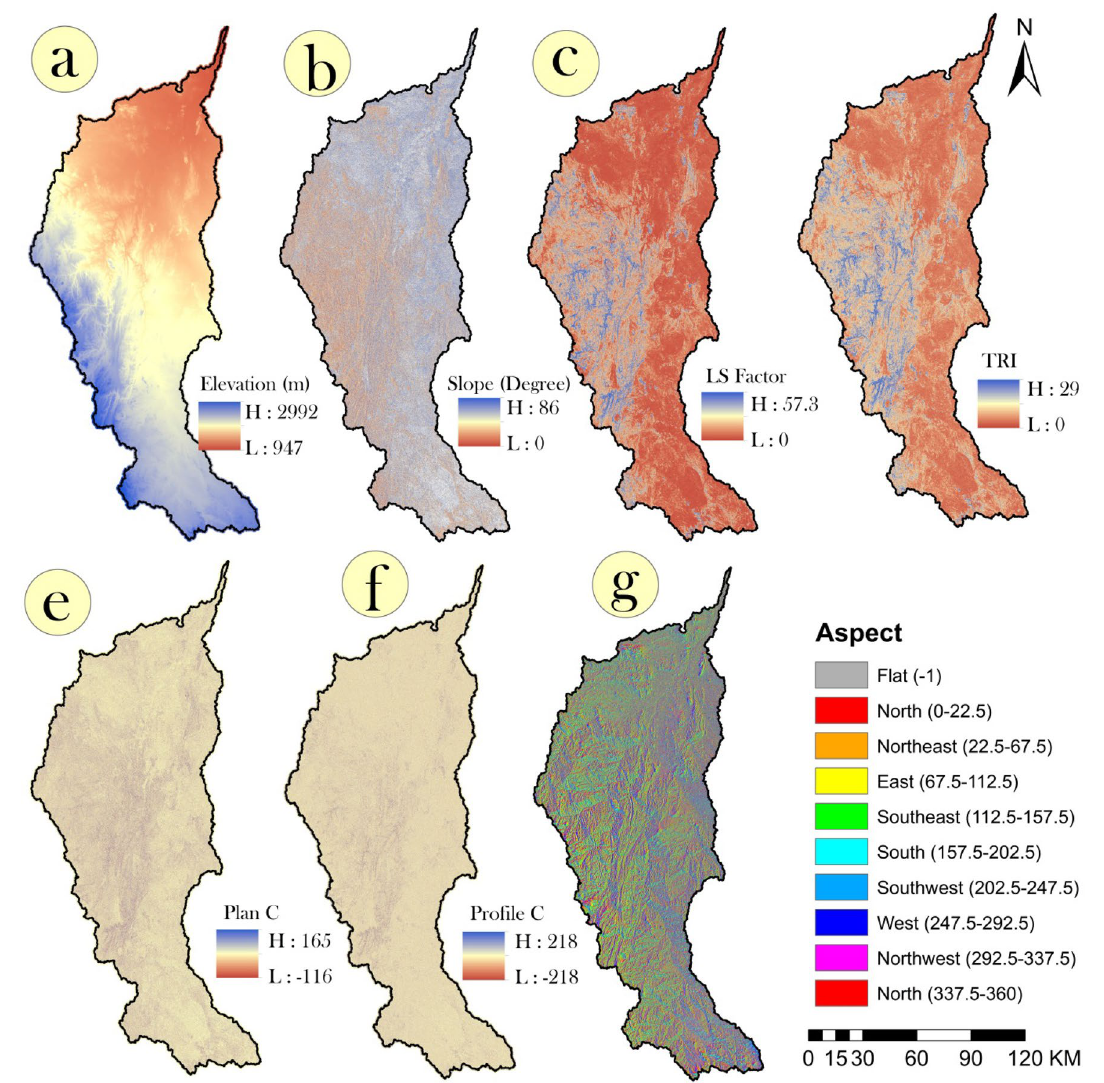
Fig. 2 DEM derived topographic parameters, such as a elevation, b slope, c LS Factor, d TRI, e plan curvature, f profile curvature, g